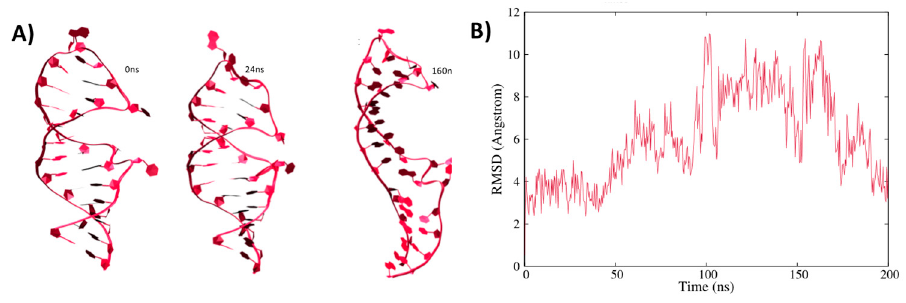
Figure 1. Representative snapshots extracted from the MD trajectory showing the structural evolution of the solvated IRE mRNA hairpin ( A ) and the corresponding RMSD ( B ).